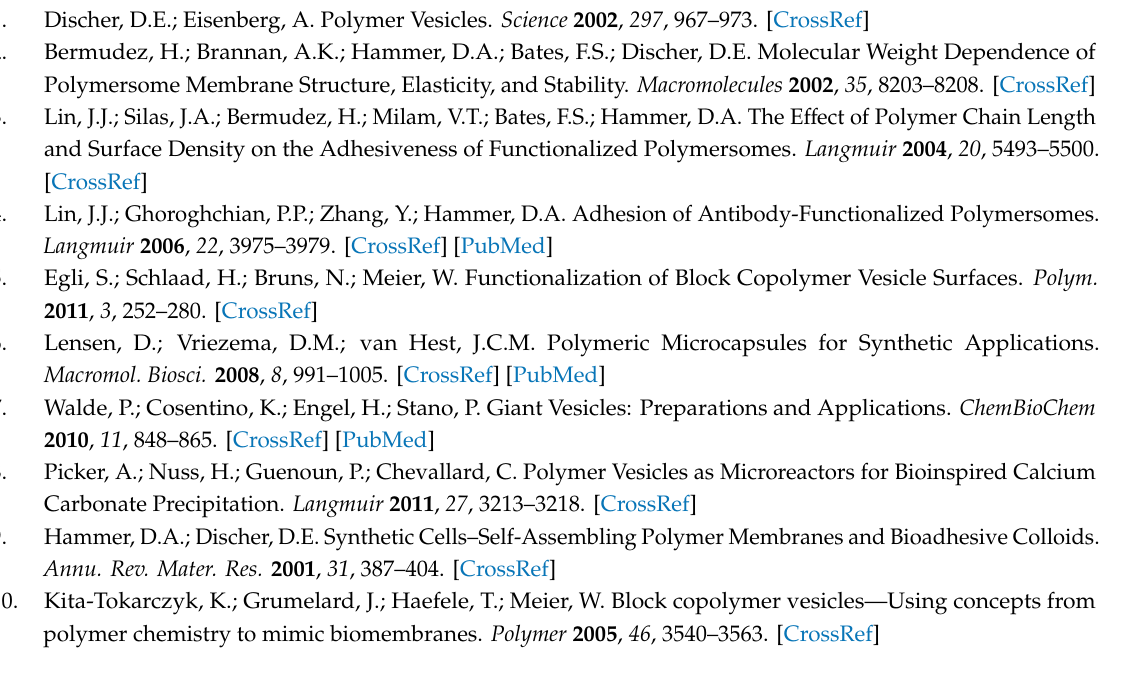
Figure S1: 1 H-NMR spectra of the PGMA macro-CTA homopolymer in D 2 O. Figure S2: DMF GPC curves obtained for a PGMA macro-CTA (black) and the corresponding PGMA- b -Ru(bpy) 3 diblock (red) and PGMA- b -Ru(bpy) 3 - b -PHPMA triblock copolymers (blue). Figure S3: 1 H-NMR spectra of the PGMA- b -Ru(bpy) 3 diblock copolymer in d6-DMSO. Figure S4: Calibration curve to determine the amount of Ru(bpy) 3 conjugated to the polymer PGMA macro-CTA. Figure S5: Oscillation profiles of redox potential at 20 ◦ C for 0.5% w / w PGMA- b -Ru(bpy) 3 solutions. Figure S6: Oscillation profiles of redox potential for control experiment. Figure S7: Oscillation profiles of redox potential for the synthesis of PGMA- b -Ru(bpy) 3 - b -PHPMA under the BZ reaction at di ff erent times: (a) 0h, (b) 2h, (c) 5h, (d) 10h, (e) 17h, (f) 24h. Figure S8: XPS spectra of NaBrO 3 : a wide scan spectra (survey) (a) and Br 3d core level (b). Figure S9: XPS spectra of a wide scan spectra (survey) (a), O 1s(b),